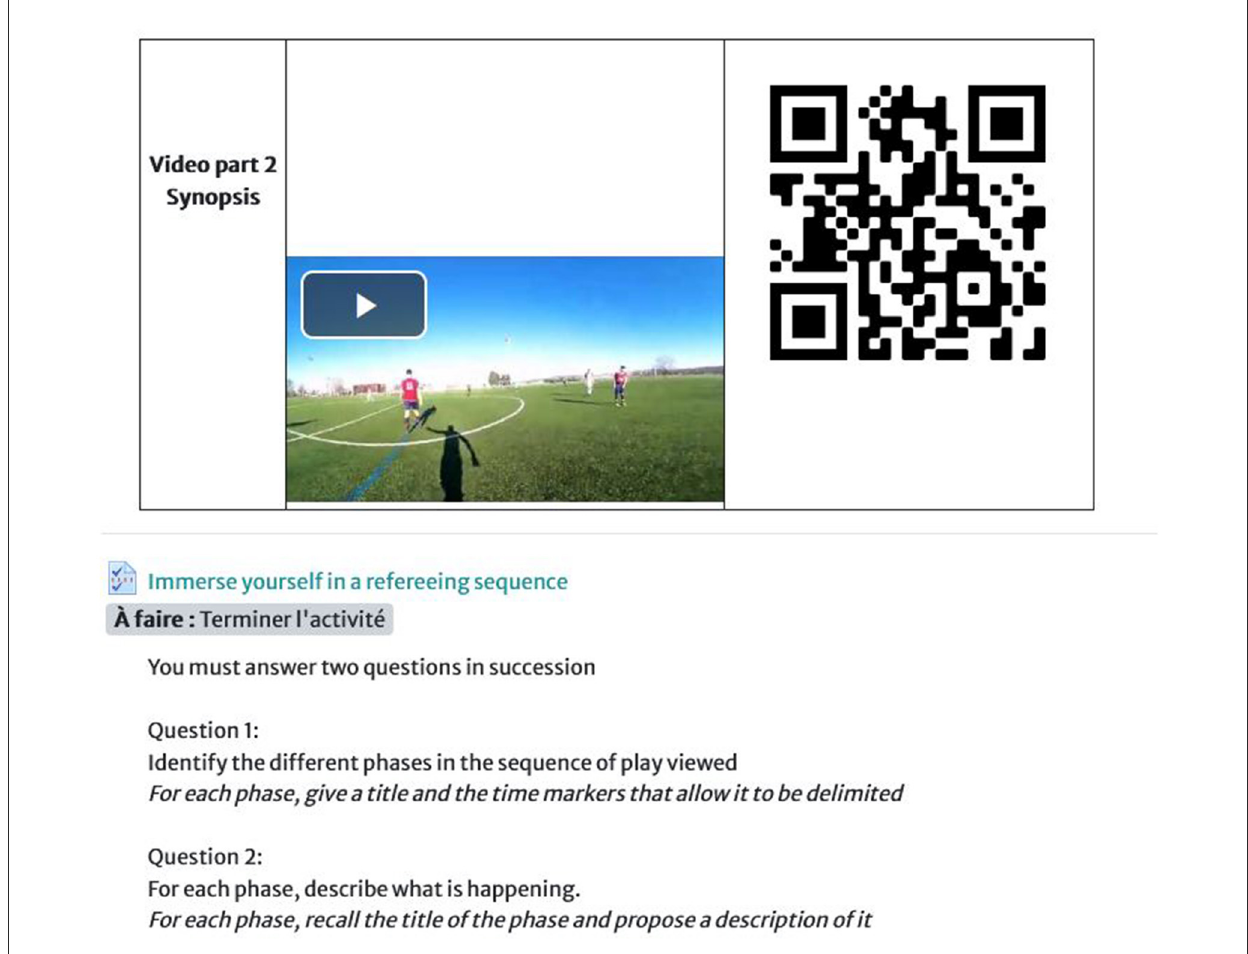
FIGURE3 Overview of the video presentation and the exercise for referees.